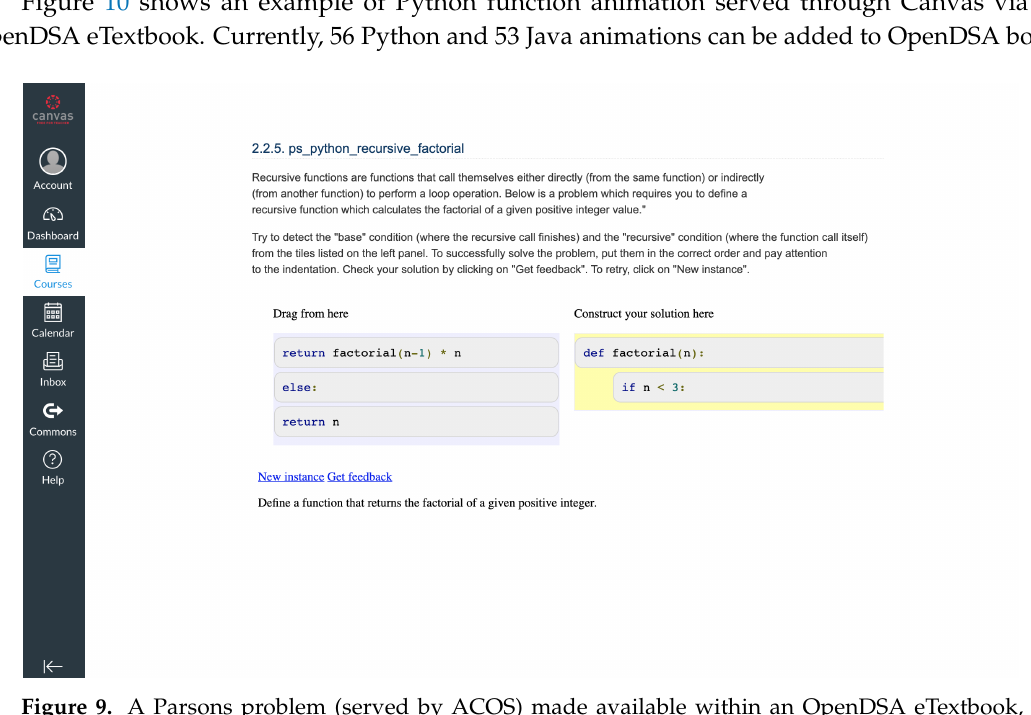
Figure 9. A Parsons problem (served by ACOS) made available within an OpenDSA eTextbook, delivered via